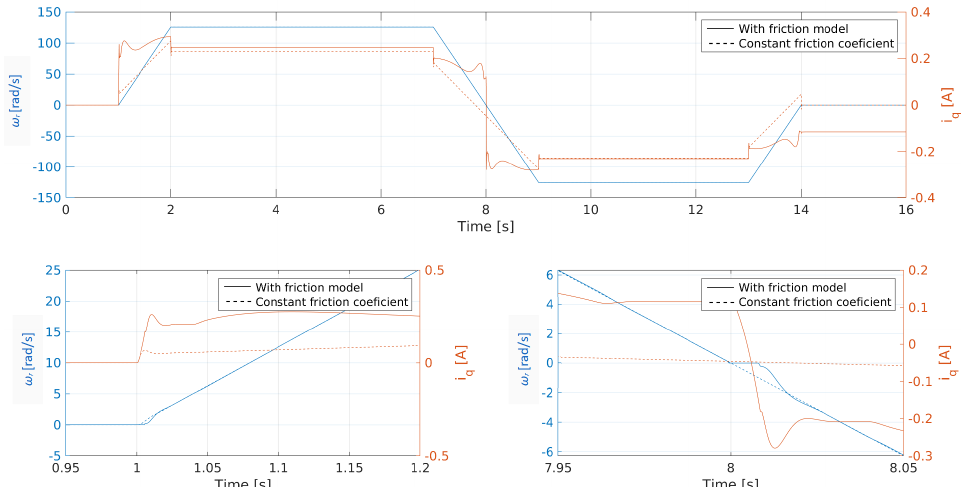
Figure 7. A simulation of a simple movement of the actuator without load, where the angular velocity of the motor is blue and the torque-generating current is red. Continuous lines represent the simulation with the presented friction model, whereas dashed lines represent the simulation with the basic friction modelling. The upper plot shows the whole movement, the bottom-left plot shows the movement start in detail, and the bottom-right plot shows the stiction effect during speed